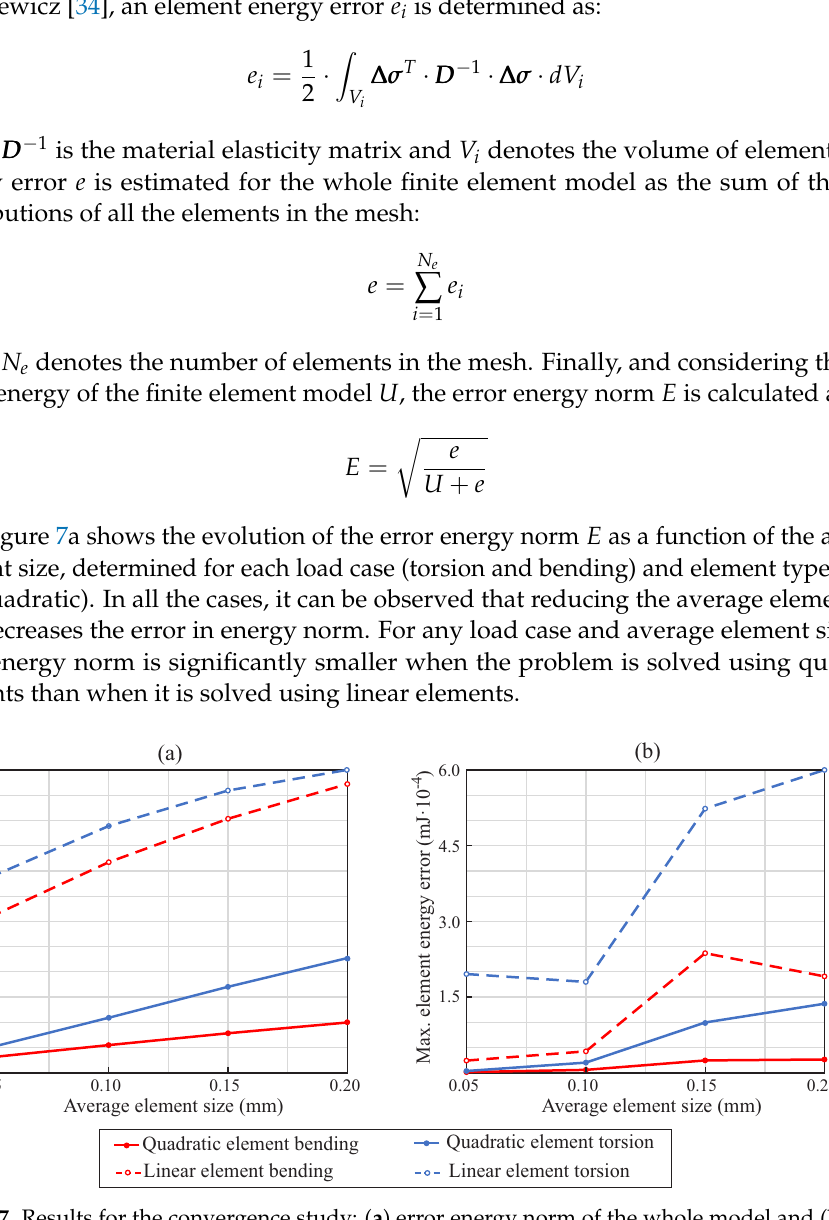
Figure 7. Results for the convergence study: ( a ) error energy norm of the whole model and ( b ) maxi- mum element energy